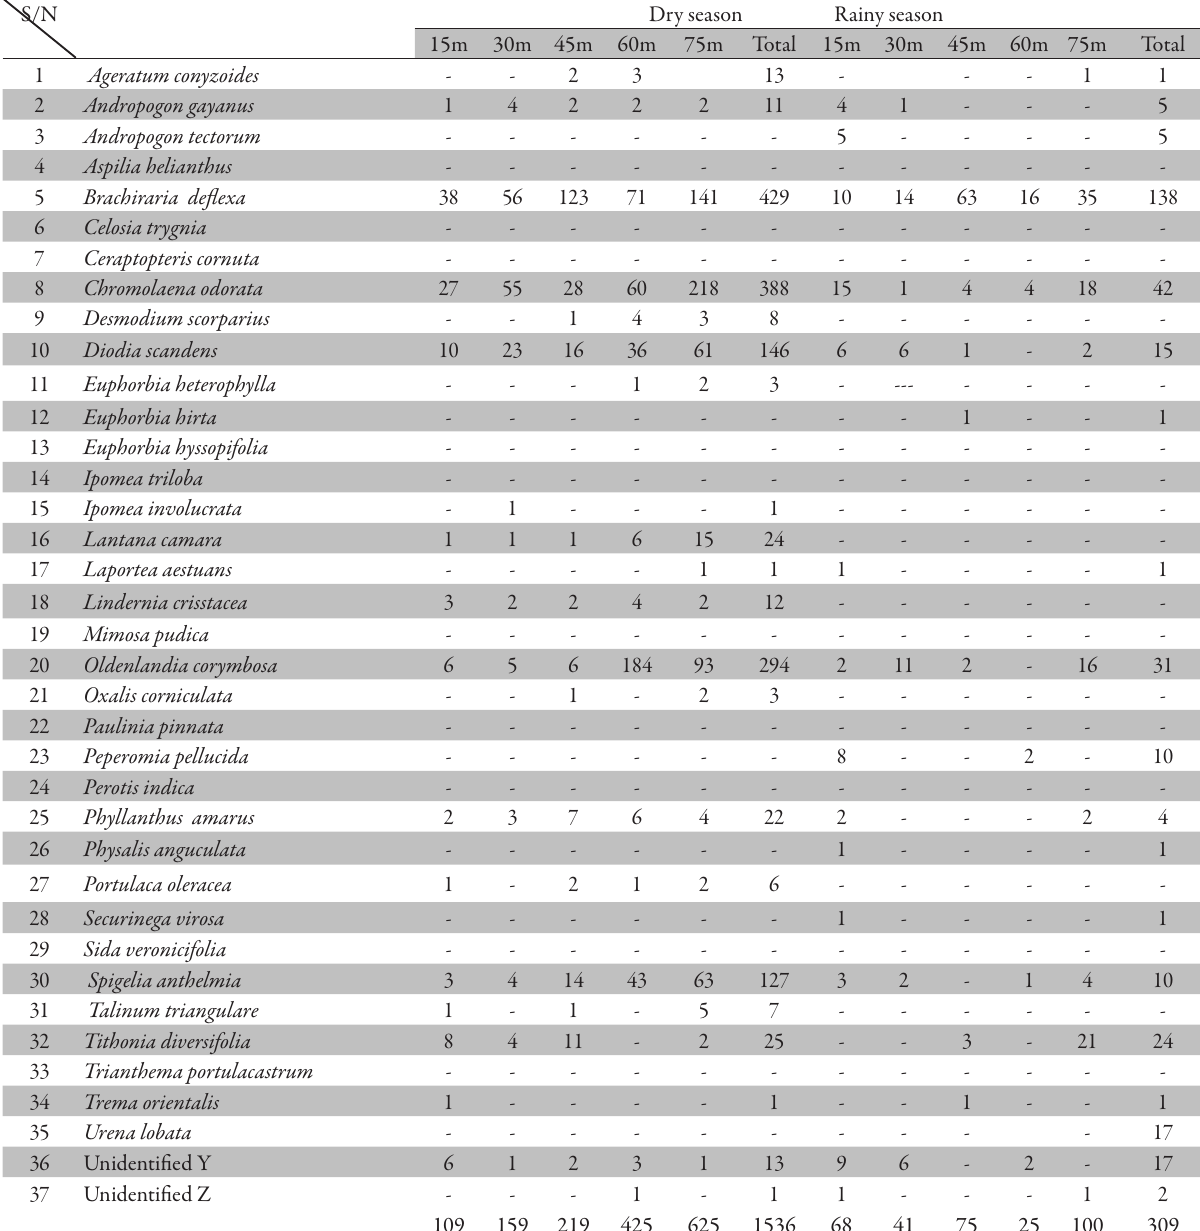
Tab. 4. Seedlings Emergence in relation to the extent of the fallowland in the study site 2 in both